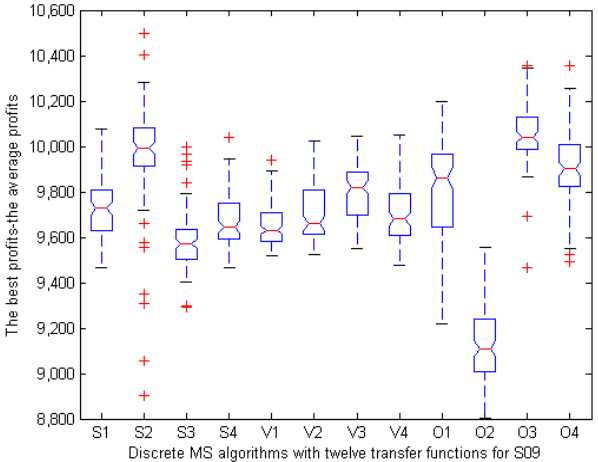
Figure 4. Boxplot of the best values on F09 in 100 runs.